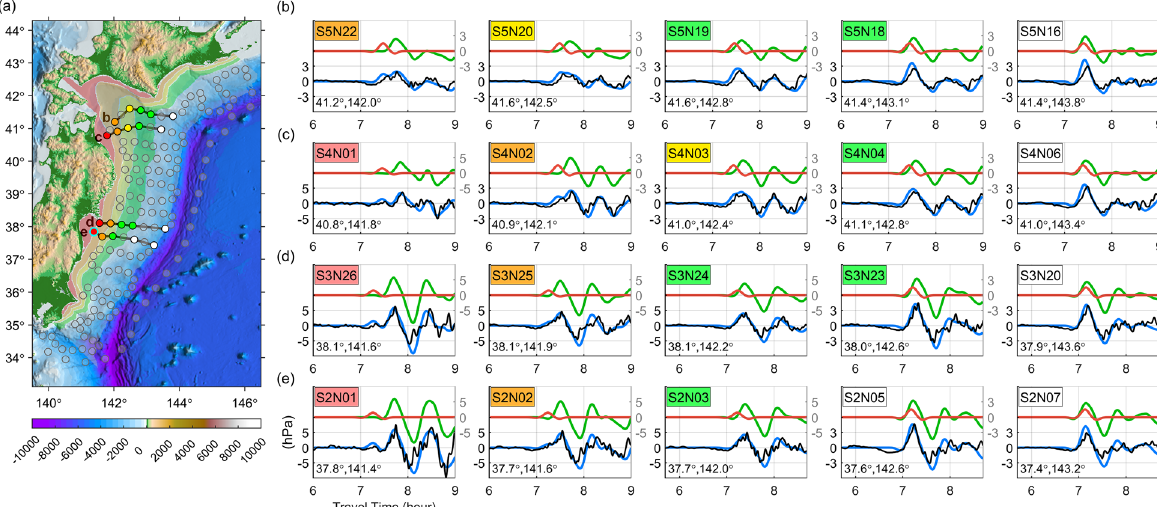
Fig. 4 S‑net stations and observed OBP waveforms compared to the simulated waveforms of air pressure, sea surface, and bottom pressure. a The circles represent the locations of S‑net stations. The areas shaded by white, green, yellow, orange, and red indicate the areas where (cid:31) t was < 6, 6–12, 12–18, 18–30, and > 30 min, respectively. The stations connected with dark lines are those color coded to match the corresponding (cid:31) t values. The waveforms of those stations are shown in b – e from north to south. The light blue circle indicates the location of S2N01. b – e The waveforms of the stations that are connected with dark lines from north to south in a . Black lines illustrate the observed bottom pressure data. Red, green, and blue lines are the input air pressure wave, simulated sea surface heights, and simulated bottom pressures, respectively. The right y‑axes indicate the scale of the red and green lines. The background colors of the station names correspond to the circles’ fill colors in a